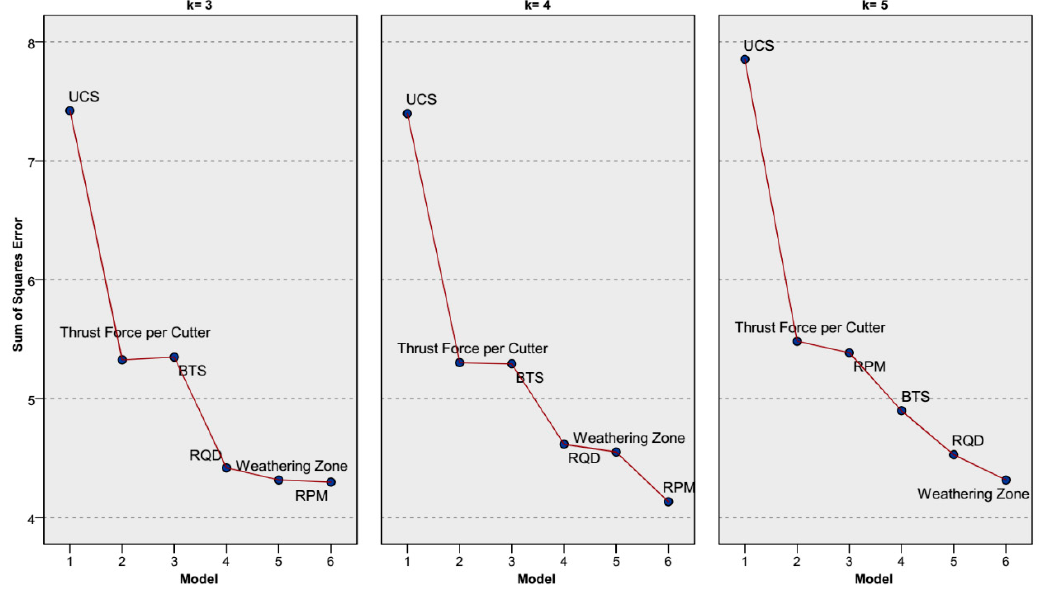
Figure 7. The relationship between the predictors and K selection.